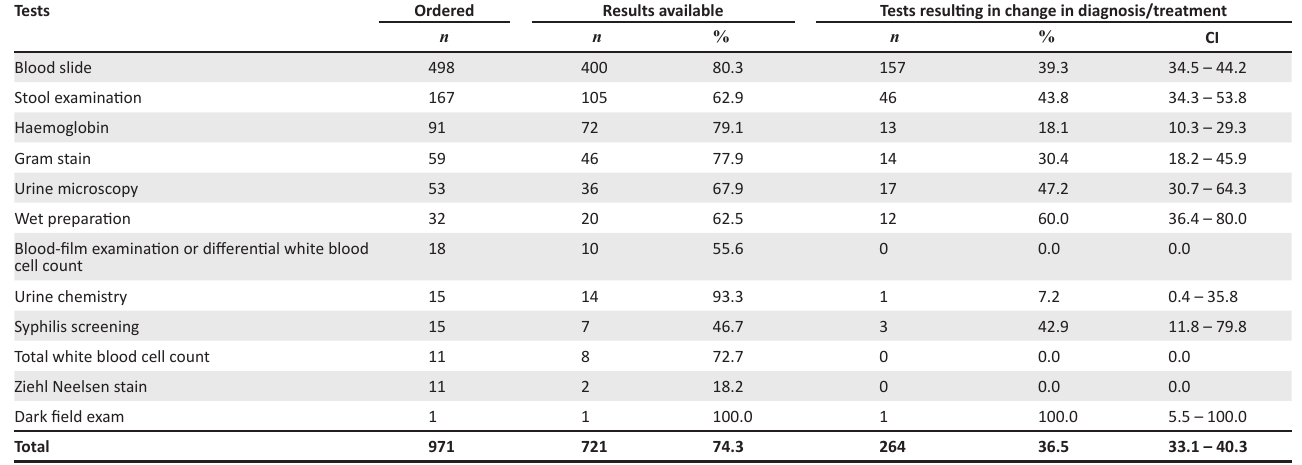
TABLE 2: Laboratory tests and their effect on diagnosis and